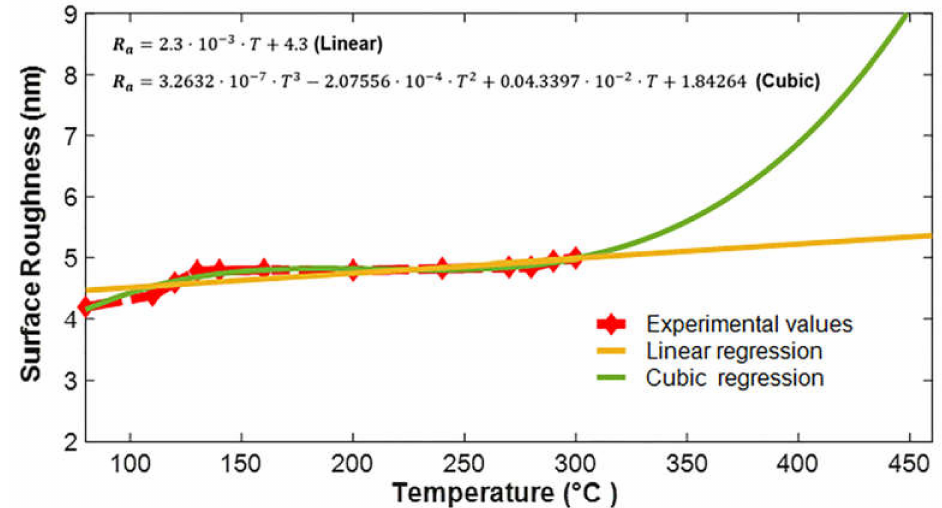
Figure 6. The prediction of surface roughness against rise in temperature in PECVD process by linear (orange) and cubic regression (green) for a higher temperature value, i.e., 450 ◦